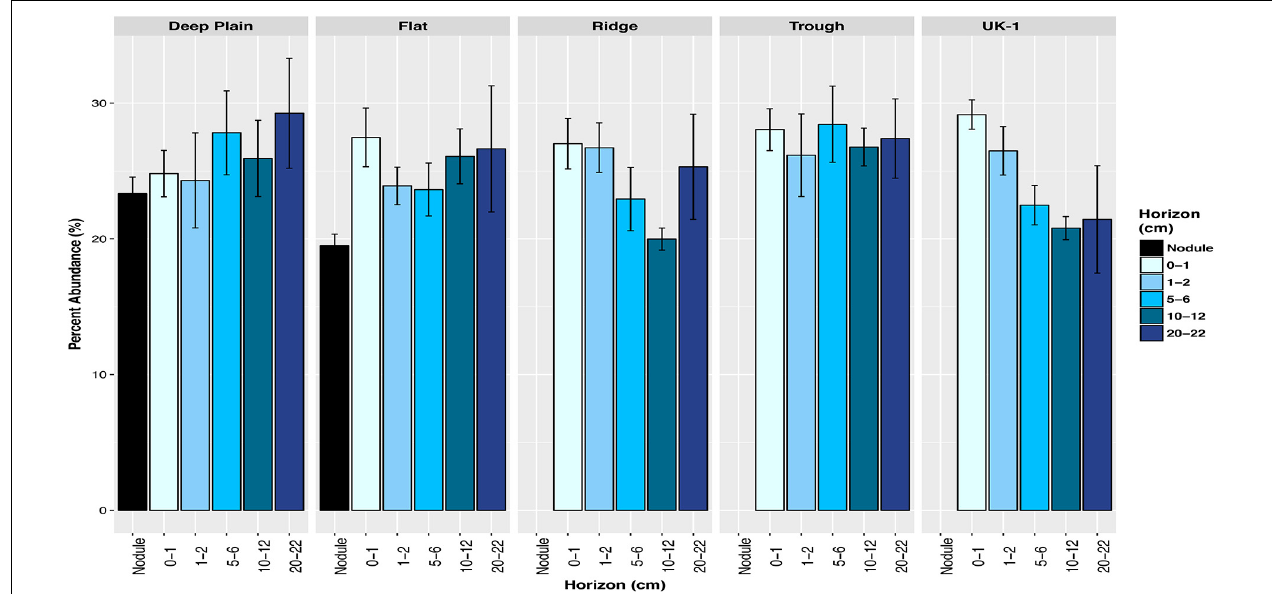
FIGURE 6 | Total relative abundances of amplicon sequence variants (ASVs) of putative carbon-fixing and nitrifying microbes in sediments and nodule-associated communities at APEI-6 and UK-1. Error bars represent standard deviation of the 3 or more replicates for each category. Relative abundances were calculated on samples that had first been normalized to account for uneven sampling depth, by scaling sequence counts by library